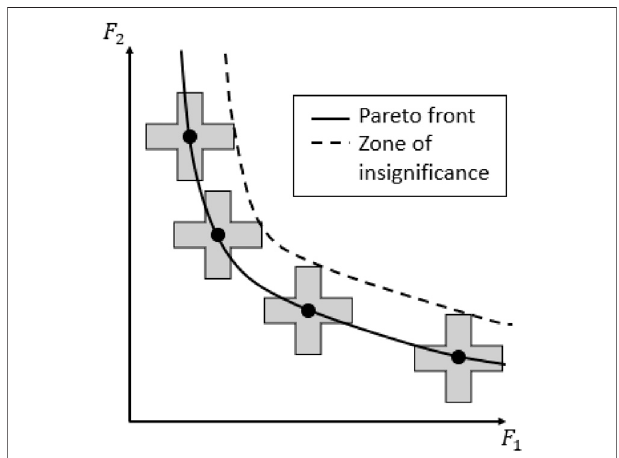
FIGURE 7 | Graphical representation of the zone of insigni fi cance of the DO2DK-problem.